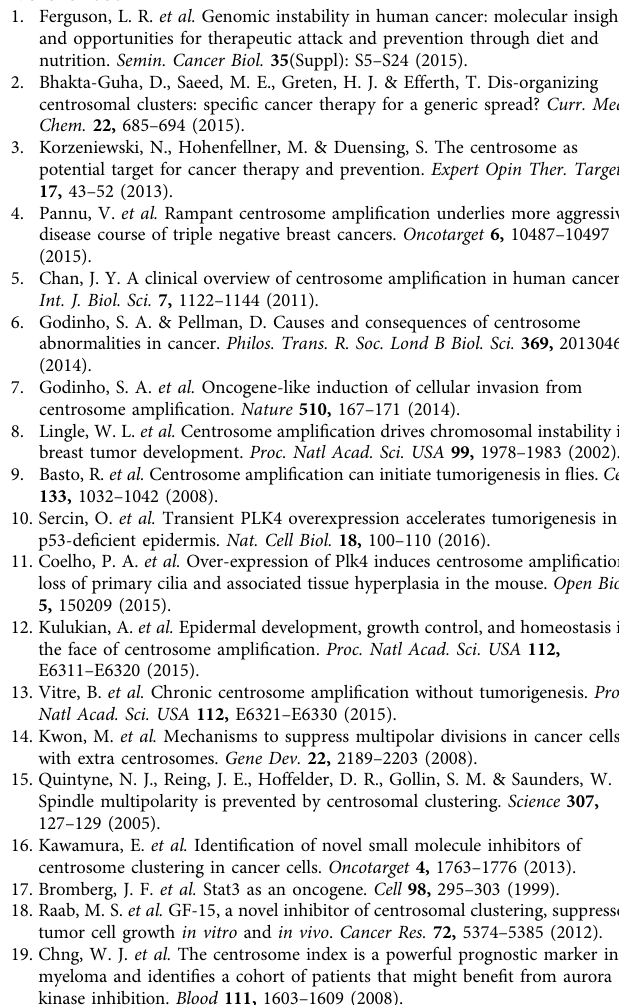
Fig. 6. Liver-derived microsome assays and UPLC-UV detection of KM08165 conversion into Stattic was performed by the Centre for Drug Research and Development (Vancouver). In silico prediction of KM08165 substructures was performed with the help of the Centre for Drug Research and